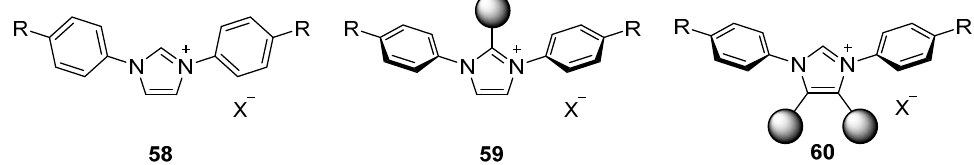
as terminal substituents.